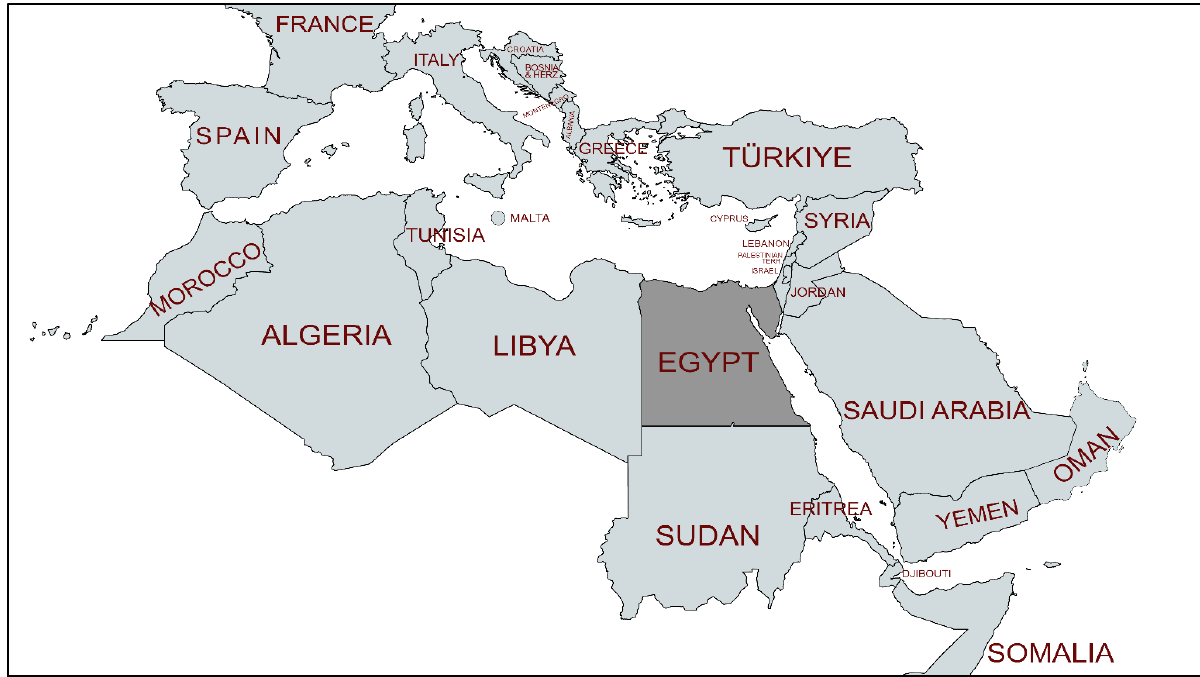
Figure 1. Map showing the location of Egypt, its surrounding water bodies (Mediterranean and Red Seas), and neighbouring countries.